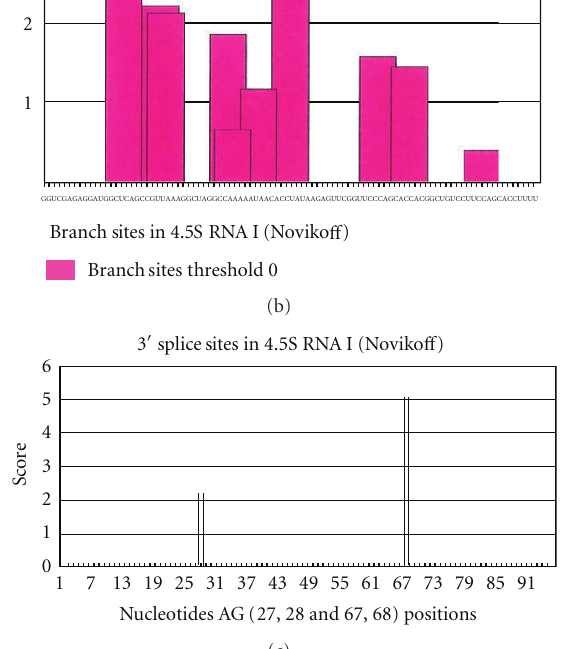
Figure 10: ESE motifs in 4.5S RNA. The sequences of 4.5S RNA I from Noviko ff hepatoma cell nuclei were screened by ESE finder 3 [13] for ESE, 5 (cid:2) splice sites, branch sites, and 3 (cid:2) splice sites. The default threshold value was used. There were 4 SF2/ASF sites, 3 SC35 sites, 6 SRp40 sites, 1 SRp55 sites, 10 branch sites, and 2 3 (cid:2) splice sites. These numbers resemble the number identified in Alu elements of human FMR1 transcript (Table 8).